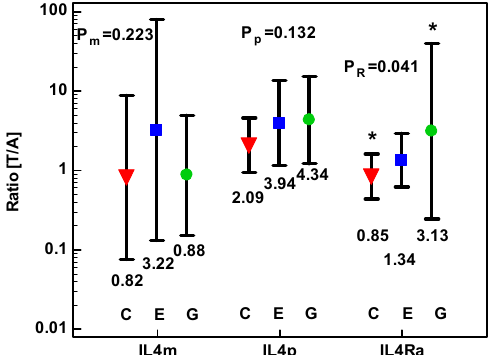
Figure 3. Effect of anatomical site on fold-change in IL4 mRNA (IL4m), IL-4 protein (IL4p), and IL4Ra expression in tumor as compared to adjacent tissue [T/A]. Data were analyzed as logs using one-way ANOVA and presented as geometric means with 95% confidence interval (whiskers). Red triangles represent mean values in colorectal cancers (denoted as C); blue squares represent mean values in esophageal squamous cell carcinoma (denoted as E); green circles represent mean values in gastric adenocarcinoma (denoted as G). p values for IL4 mRNA analysis are denoted as P m , for IL-4 protein analysis as P p , and for IL4Ra mRNA analysis as P R . Statistically significant between-group differences are marked with asterisks (*).